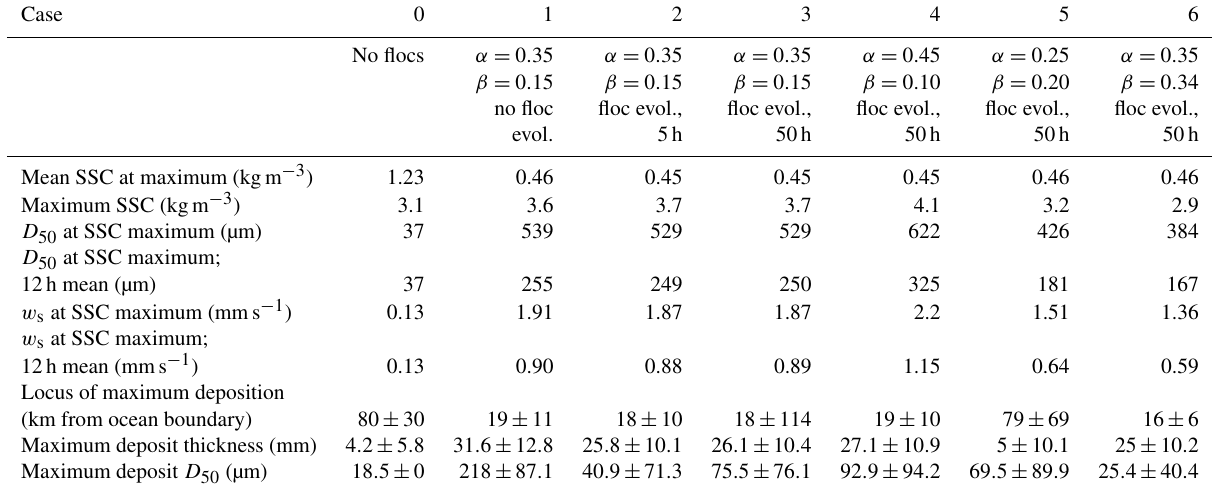
Table 1. Characteristics of the estuary turbidity maxima for seven cases under different flocculation conditions. Case